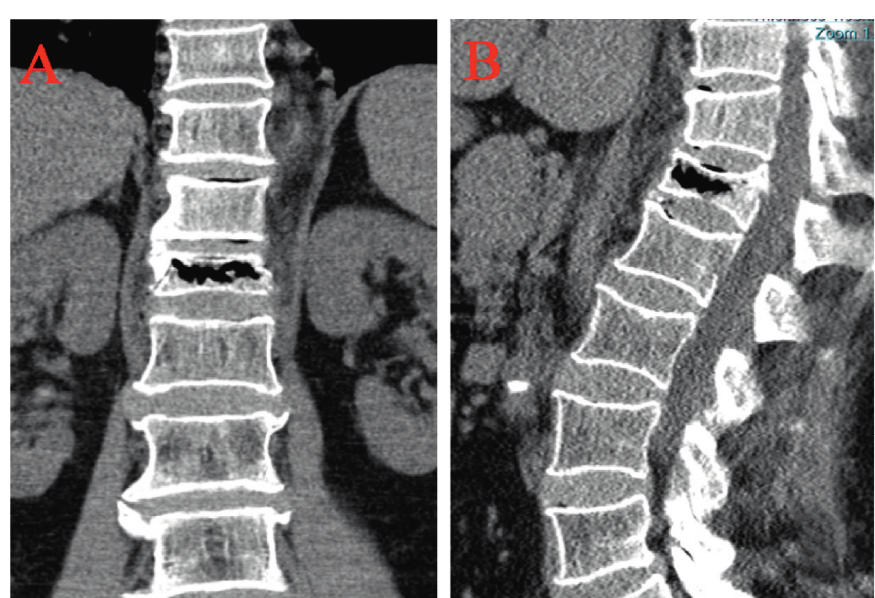
Figure 1: Patient flowchart.